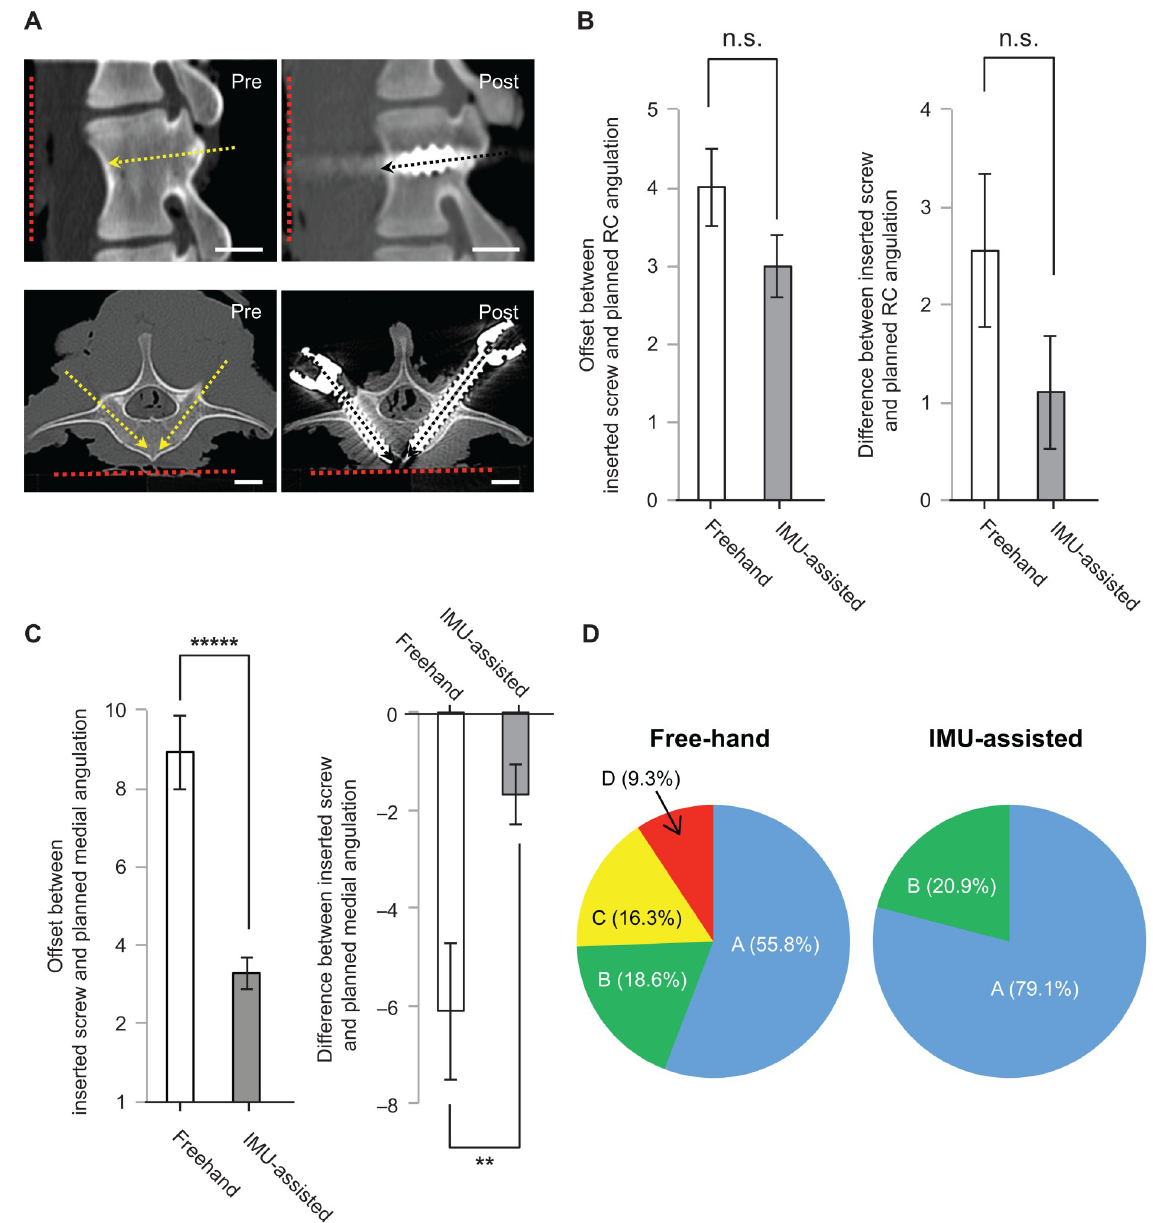
Fig 1. (a), Images of parasagittal (left) and arbitrary axial plane (right) obtained on pre- and postoperative CT scans. Scale bar: 10 um. Red dotted line indicates the surface of the board. Yellow dotted arrows indicate the planned trajectories of PSs. Black dotted arrows indicate the longitudinal axes of the inserted PSs. The left 2 panels show that the PS rostro-caudal angle was almost parallel to the planned angle. The right 2 panels show that the left PS medio-lateral angle deviated laterally relative to the planned angle, whereas the ML angle of the right PS was almost parallel to the planned angle. (b), Left), Mean offsets between the inserted PS and preoperatively planned rostro-caudal rotations about the transverse axis (see Material and methods) in the freehand and IMU-assisted groups. Right), Average difference between the inserted PS and preoperatively planned rostro-caudal rotation about the transverse axis (see Material and methods) in the freehand and IMU-assisted groups. n.s.: not significant. (c), Left),Mean offsets between the inserted PS and preoperatively planned medio-lateral rotations about the perpendicular axis (see Material and methods) in the freehand and IMU-assisted groups. Right), Average difference between the inserted PS and preoperatively planned medio-lateral rotations about the perpendicular axis (see Material and methods) in the freehand and IMU-assisted groups. ����� : p < 0.00001, �� : p < 0.01. (d), Pie charts demonstrating the proportion of positioning of PS in the freehand and IMU-assisted groups according to the Gertzbein and Robbins classification